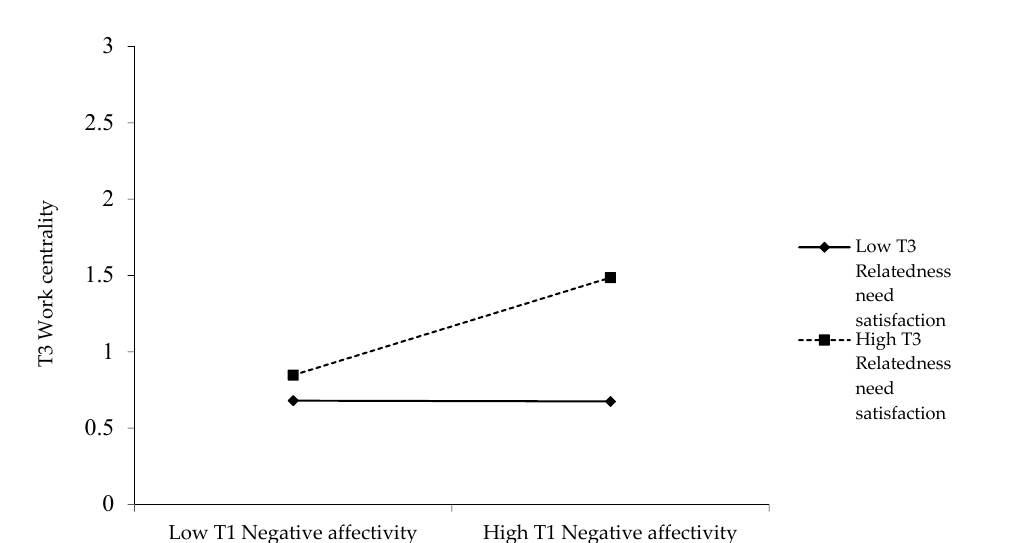
Figure 2. Interaction between Time 1 Negative Affectivity and Time 3 Relatedness Need Satisfaction predicting Time 3 Work Centrality.